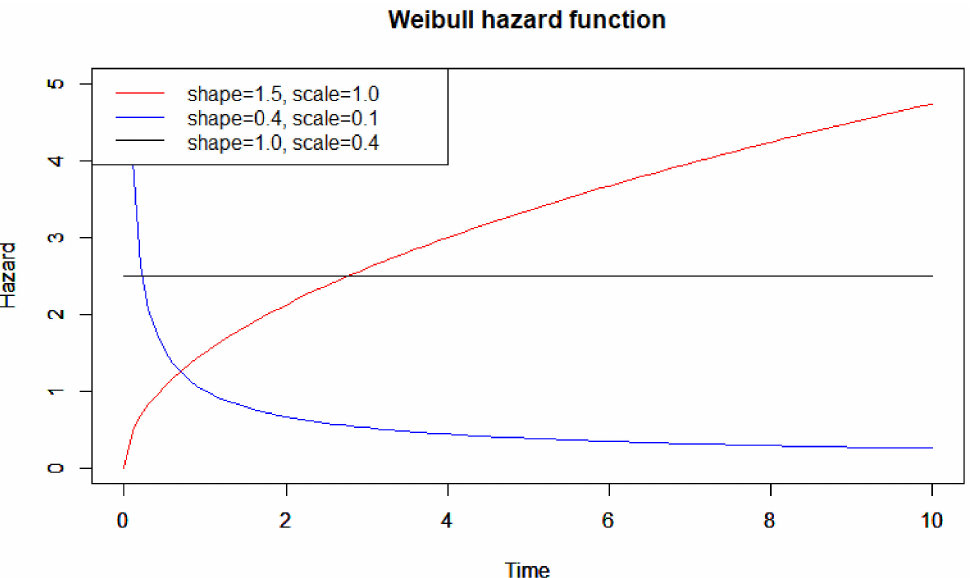
Figure 2. The shape parameter α i and the scale parameter λ i used in the simulation study for the